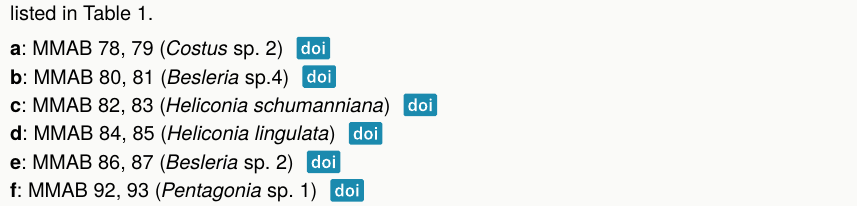
Diversity of putatively bird pollinated plants of the Manú Gradient. MMAB collection numbers listed in Table